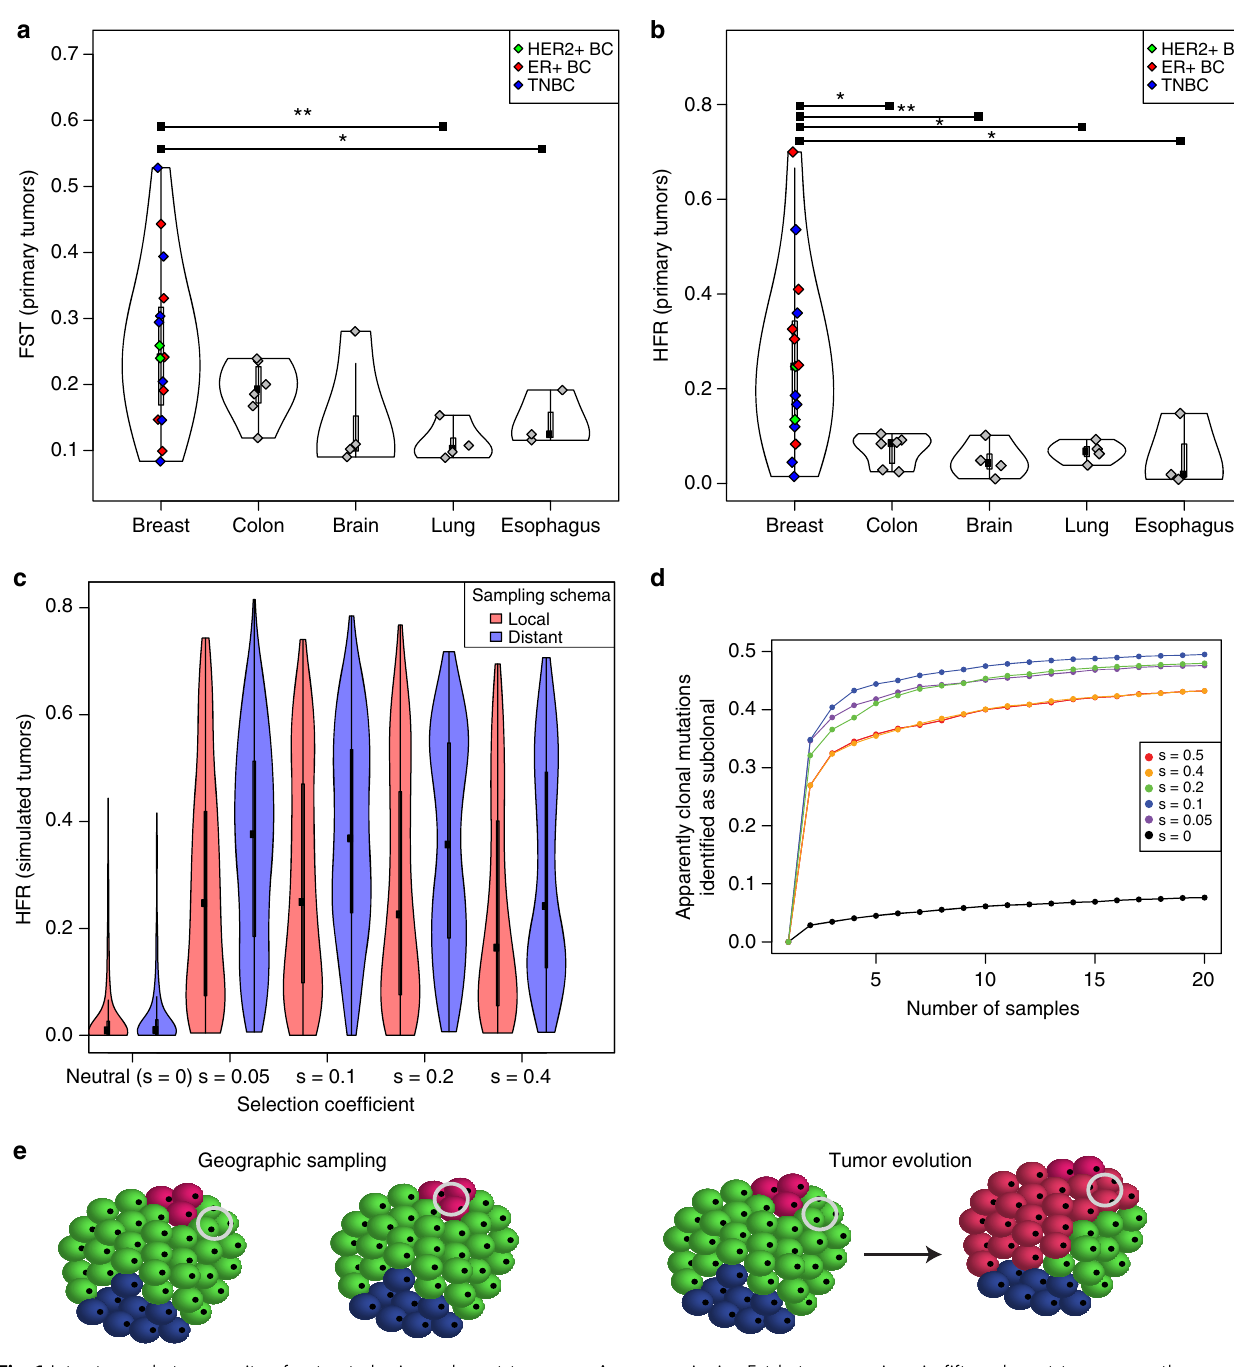
Fig. 1 Intra-tumor heterogeneity of untreated primary breast tumors. a Average pairwise Fst between regions in fi fteen breast tumors vs other untreated primary tumors: colon adenocarcinoma 20 , glioma/gliobastoma (brain) 21,22 , lung adenocarcinoma 23,24 , and esophageal adenocarcinoma 25 . * p < 0.05, ** p < 0.01 (two-sided t- test). b Average pairwise HFR (high-frequency regional) in breast vs other tumors. HFR corresponds to the percentage of high-frequency mutations from one region that are absent or rare in a second region. c HFR across tumors simulated with varying degrees of selection conferred by driver mutations. Local samples were taken from the same octant of the virtual tumor and distant samples were from distinct octants. d In virtual tumors, the mean proportion of apparently clonal (cancer cell fraction > 0.5) mutations in one region that were reclassi fi ed as de fi nitively subclonal (cancer cell fraction < 0.1) upon sampling 1 – 19 additional regions at random, with varying degrees of selection. e Schematic demonstrating how, in tumors with high intra-tumor heterogeneity, geographic sampling may mimic tumor evolution. The different colored tumor cells represent distinct clones within the tumor and the silver circles indicate sampled regions. BC breast cancer, TN triple-negative. Source data for panels a – d are provided as a Source Data fi